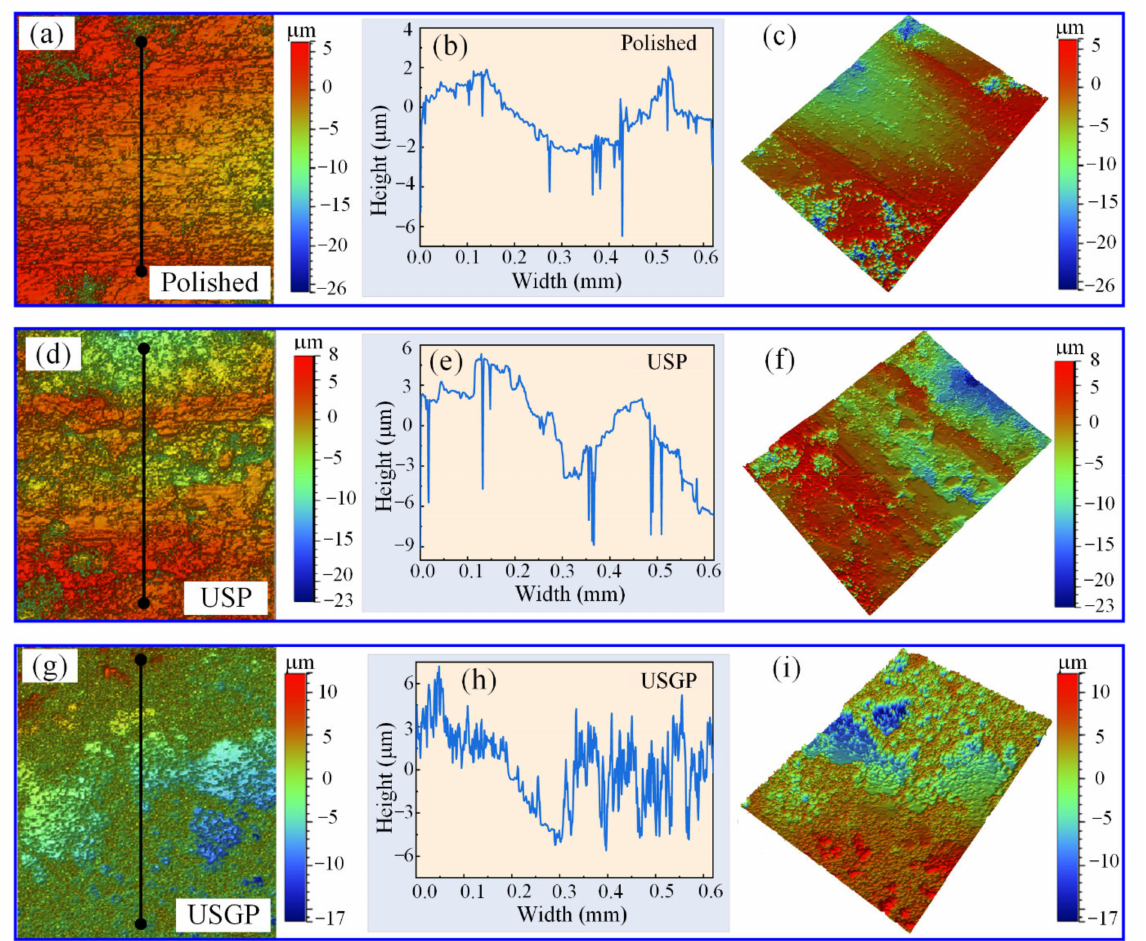
Figure 15. The micromorphology and cross-sectional profiles that took in the middle of the wear tracks of polished ( a – c ), USP ( d – f ), and USGP samples ( g – i